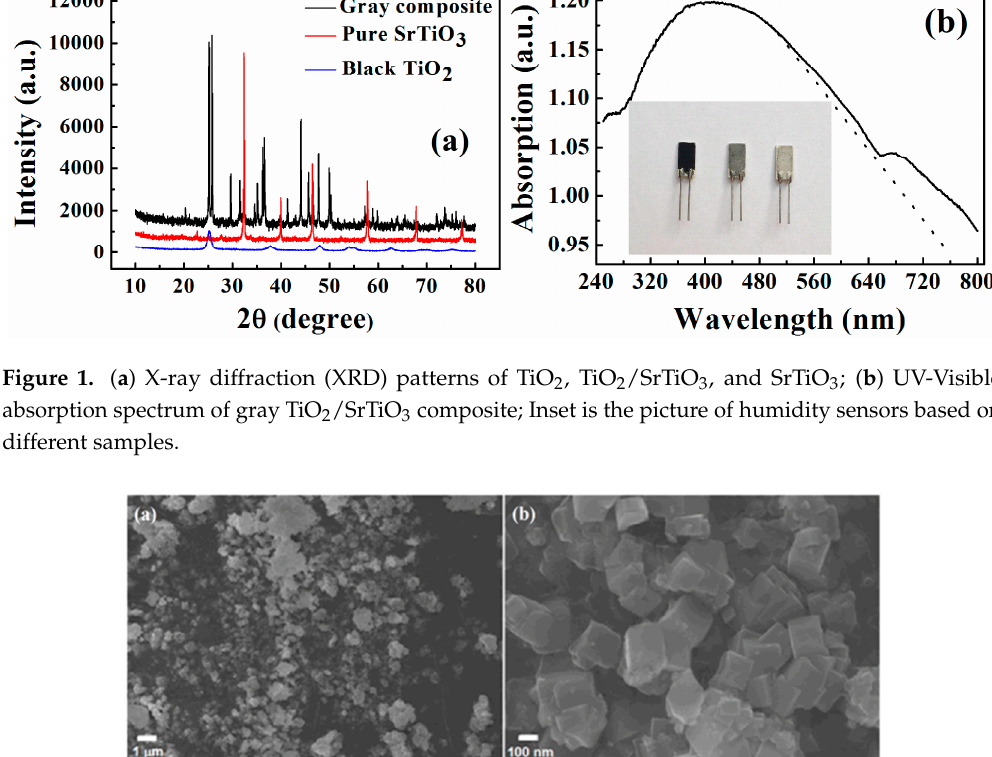
Figure 3. ( a ) Impedance versus relative humidity (RH) curves of TiO 2 /SrTiO 3 humidity sensor at various frequencies; ( b ) The Impedance versus RH curves of sensors based on different samples.